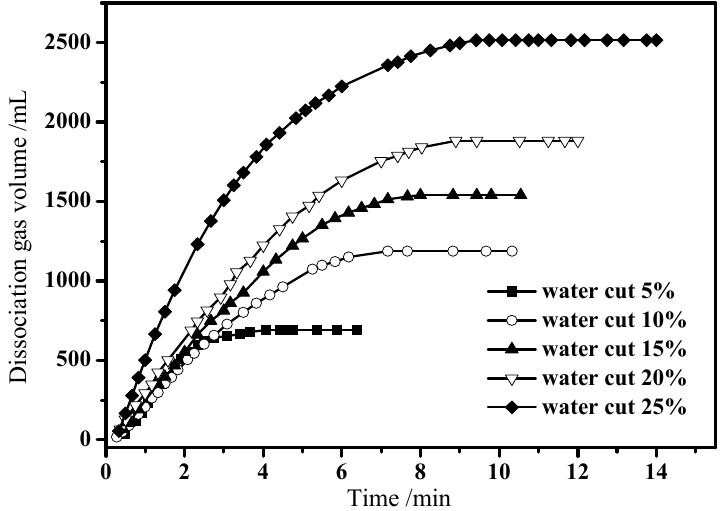
Figure 9. Variation of the quantity of decomposed gases with time in the process of natural gas hydrate dissociation in